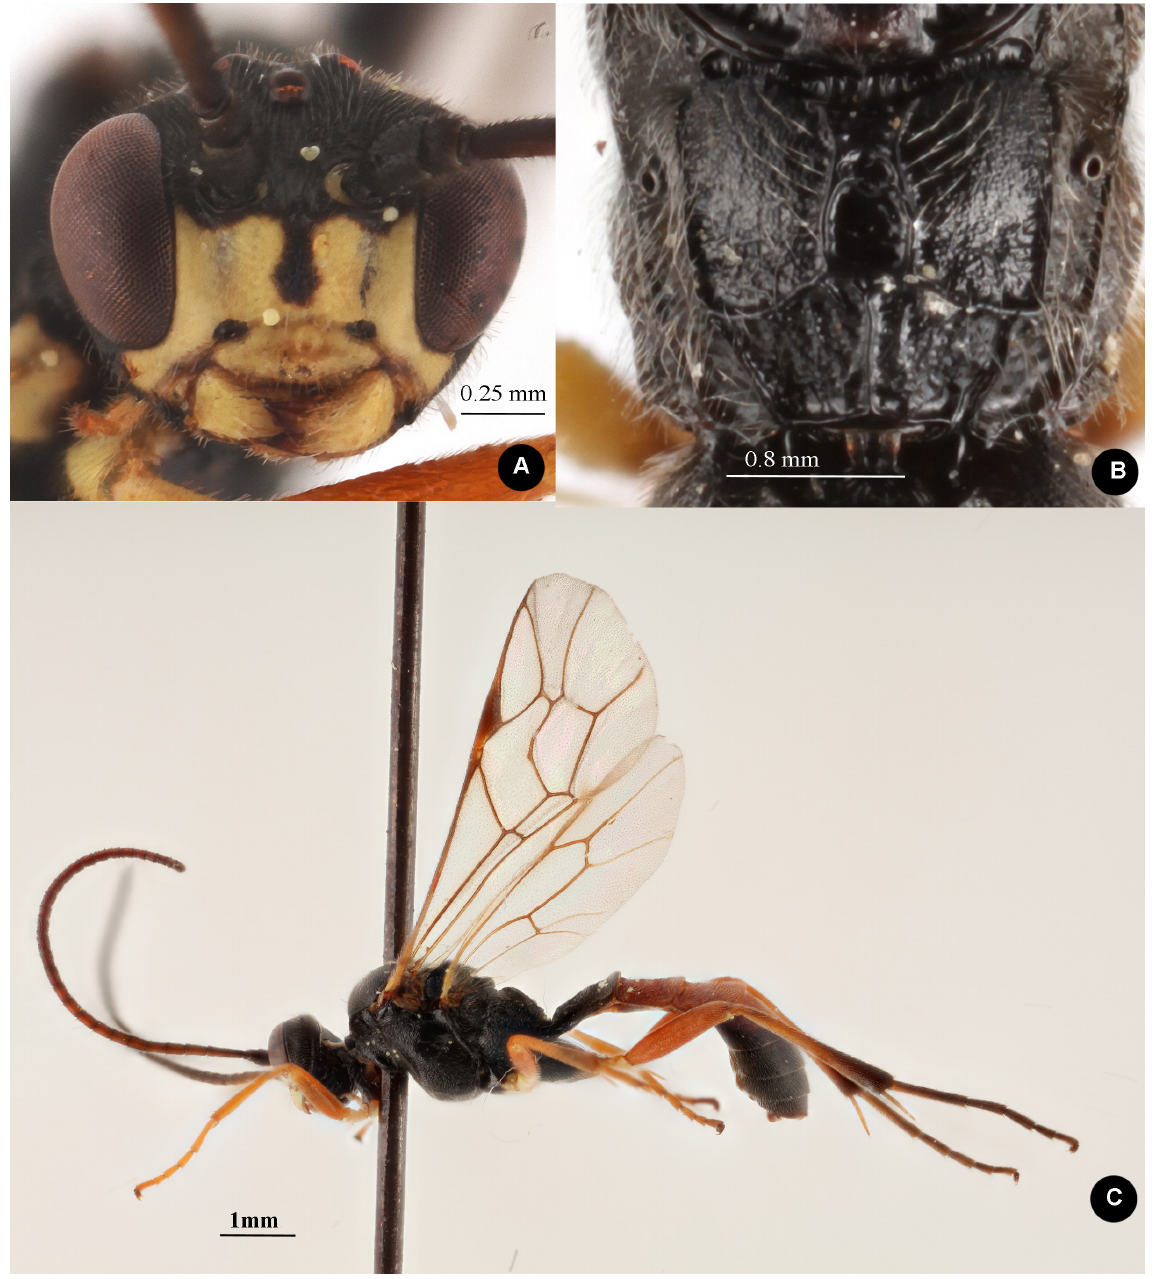
Fig. 12. Rhinotorus similis (Brischke, 1892), ♂. A . Face. B . Propodeum. C .